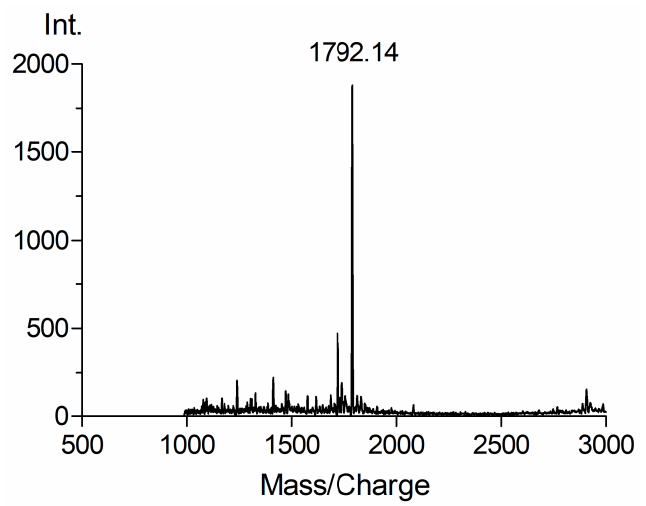
Figure 2. MALDI-TOF mass spectrum of vancomycin derivative V b.